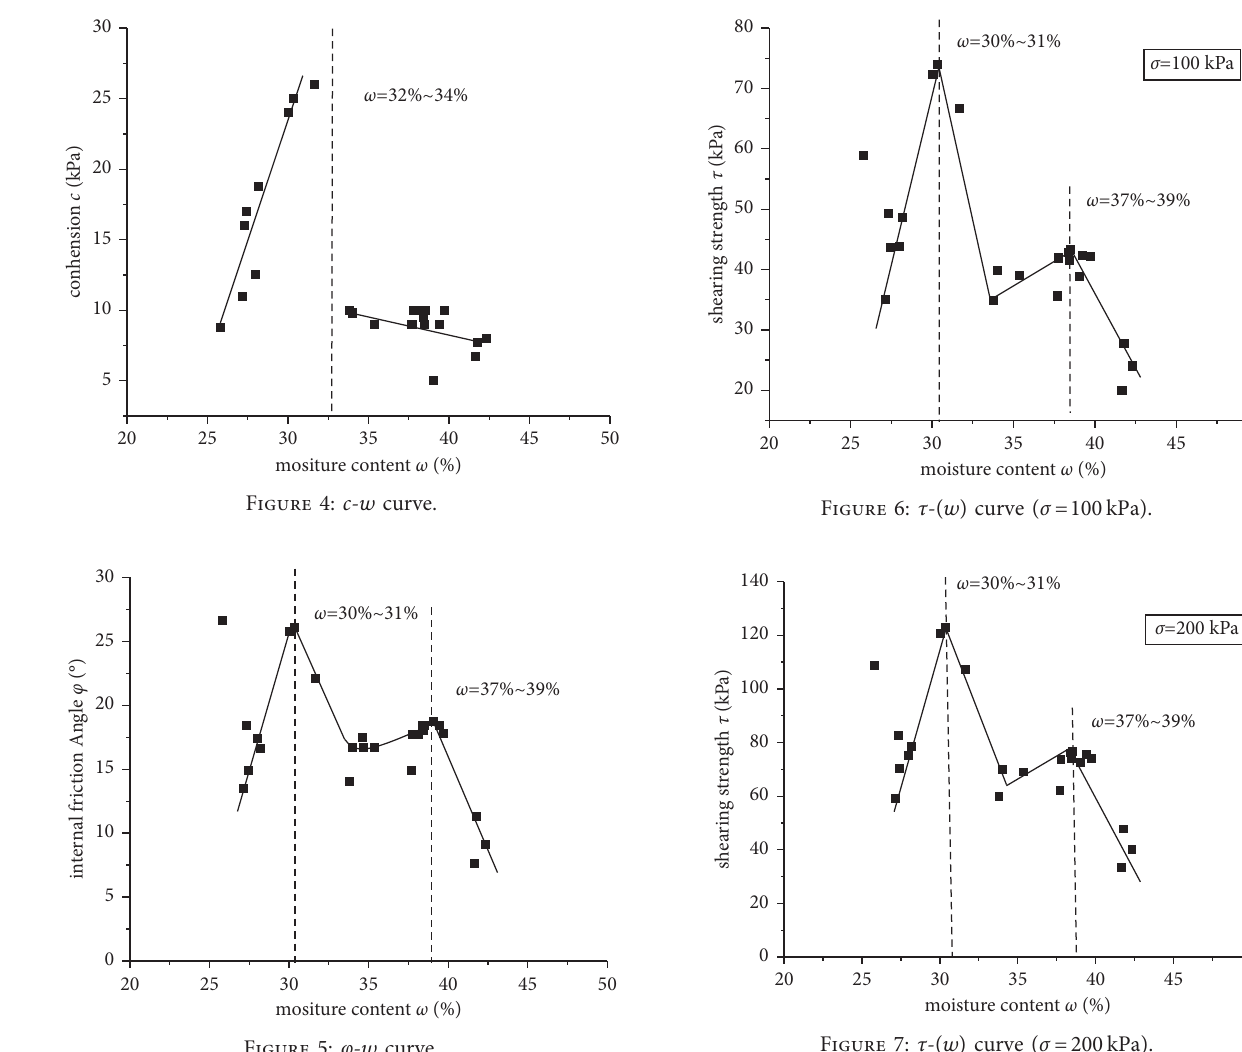
Figure 5: φ - w curve.